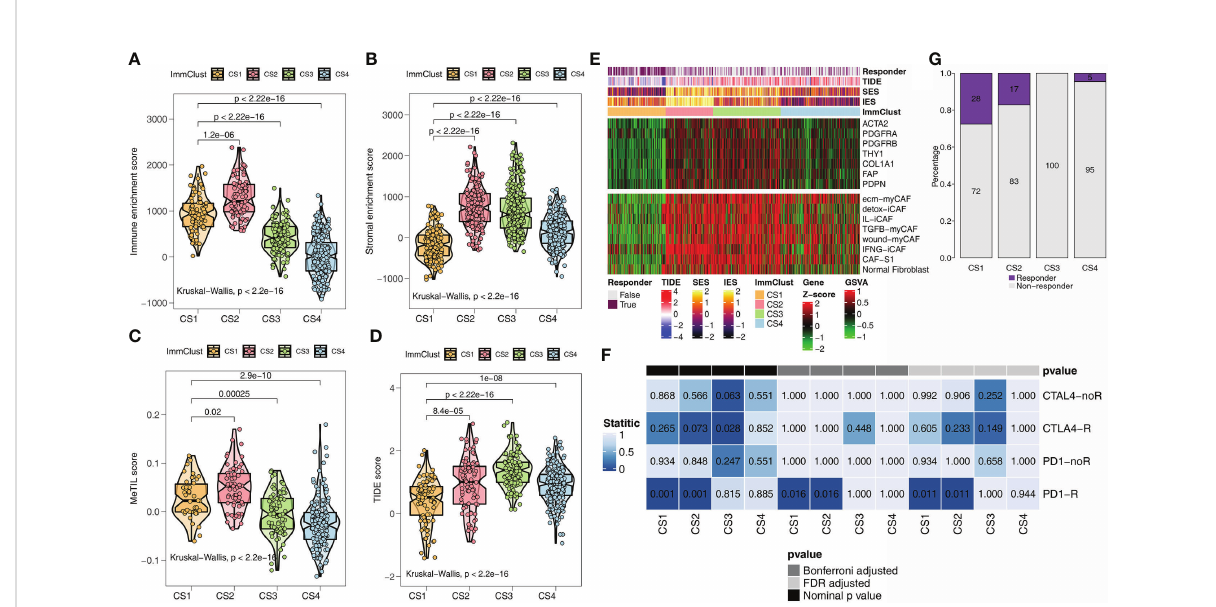
FIGURE 2 Immunotherapy response analysis for the TCGA. (A) Immune enrichment score for the four ImmClusts. (B) Stromal enrichment score for the four ImmClusts. (C) MeTIL score for the four ImmClusts. (D) TIDE score for the four ImmClusts. (E) Response to immunotherapy of the four ImmClusts. (F) The heatmap showed the differences in the distribution of the four ImmClusts in cancer-associated fi broblast (CAF)-related genes and signatures. (G) SubMap analysis for the four